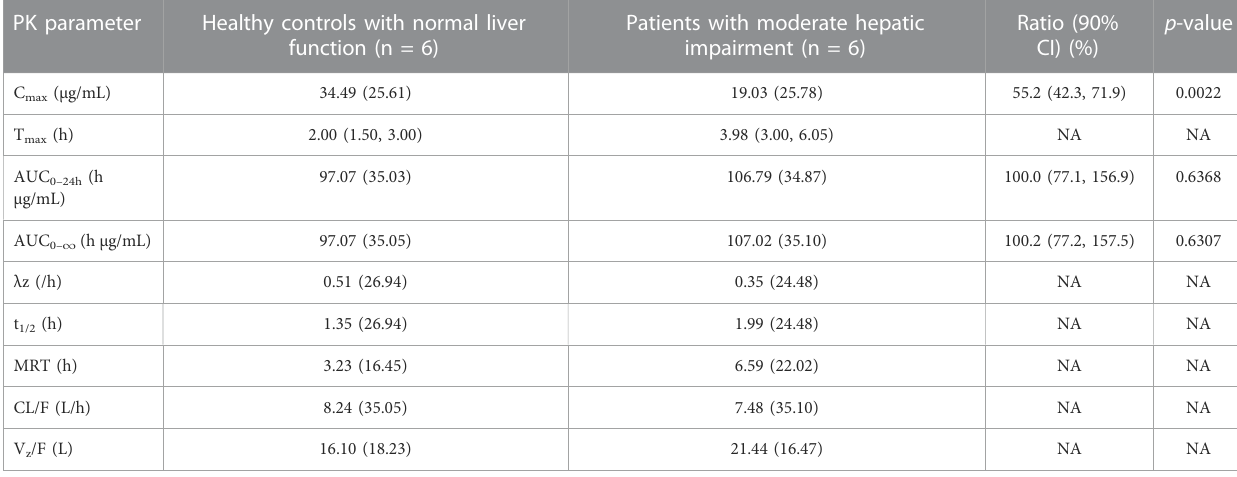
TABLE 2 Pharmacokinetic parameters of contezolid in patients with moderate hepatic impairment versus the healthy controls with normal liver function after single oral dose administration of 800 mg contezolid. PK